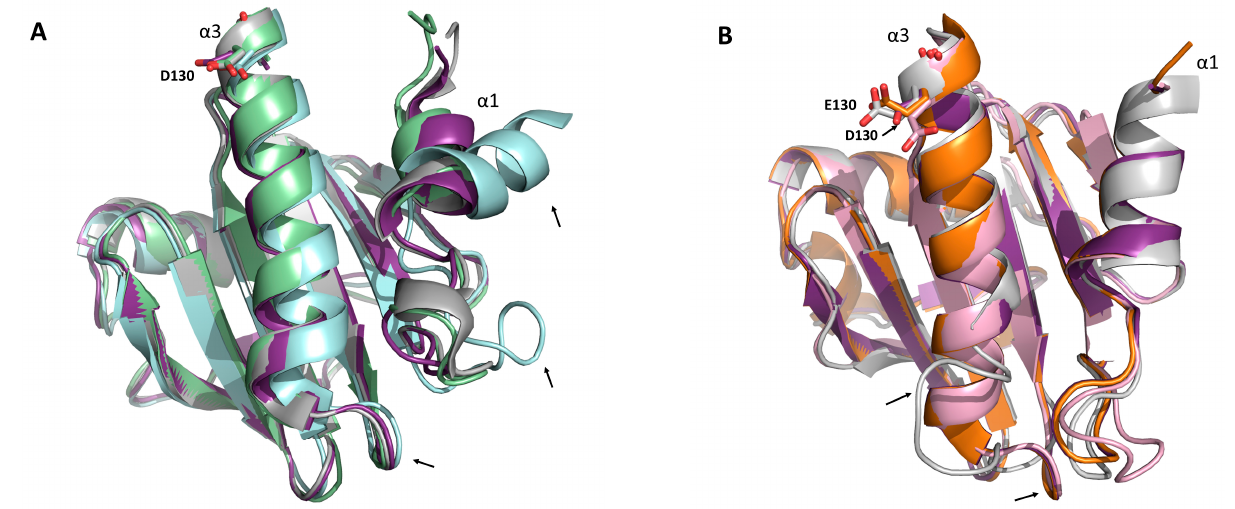
Figure 5. Structural comparisons of profilins which are highly and less recognized by the mAb 2D10. ( A ) Three-dimensional alignment of rHev b 8 (PDB 5FDS) (violet purple) shows the conserved D130 residue of Art v 4 (PDB 5EM0, gray), Amb a 8 (PDB 5EM1, green), and Bet v 2 (PDB 5NZB, cyan). The structural alignment of Hev b 8 with these three profilins corresponds to an RMSD of 0.7Å for Art v 4 and Amb a 8, and 0.9Å for Bet v 2. ( B ) Three-dimensional alignment of rHev b 8 (violet purple) that contains a D130 compared to the less-recognized profilins with a conserved E130. Fra e 2 is colored in pink (model obtained with AlphaFold), Zea m 12 (PDB 5FEF, orange), Phl p 12 (PDB 7KYW, gray). The RMSD of Zea m 12 compared with Hev b 8 is 0.3 Å, for Phl p 12 is 0.5 Å, and 0.4 Å for Fra e 2. The black arrows highlight the profilins’ structural differences.